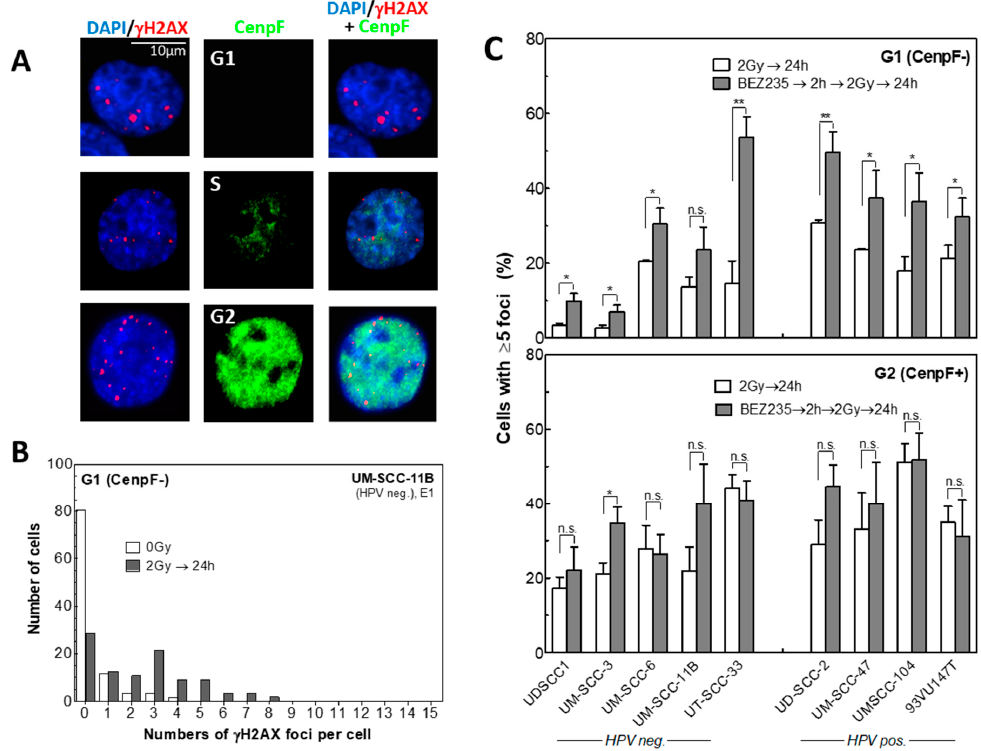
Figure 3. E ff ect of BEZ235 on double-strand break (DSB) repair in HPV neg. and pos. cell lines. Exponentially growing cells were incubated with 50 nM BEZ235 for 2 h prior to 2 Gy irradiation and examined after 24 h. ( A ) γ H2AX foci detection and co-staining of centromere protein F (CenpF) to discriminate between G1 (CenpF-, negative), and G2 (CenpF+, positive) phase cells. Scale bar is shown at the image. ( B ) Distribution of the number of residual γ H2AX foci per nucleus, as determined for UM-SCC-11b cells 24 h after 0 Gy or 2 Gy irradiation in G1 cells. ( C ) Percentage of cells with ≥ 5 γ H2AX foci per nucleus in G1 (upper panel) cells or in G2 (lower panel) cells. Significant differences between conditions are shown with one (p-value < 0.05) or two asterisks (p-value < 0.01). After treatment with 2 Gy, the fraction of cells with ≥ 5 residual γ H2AX foci measured per cell was generally higher for HPV pos. cells. This is well in line with previous data showing that HPV pos. HNSCC cells are defective in DSB repair [24,25]. When this fraction of residual foci was plotted vs. the Akt status, no association was seen for Akt, and only trends for pAkt, or the ratio of both (Figure S3A).